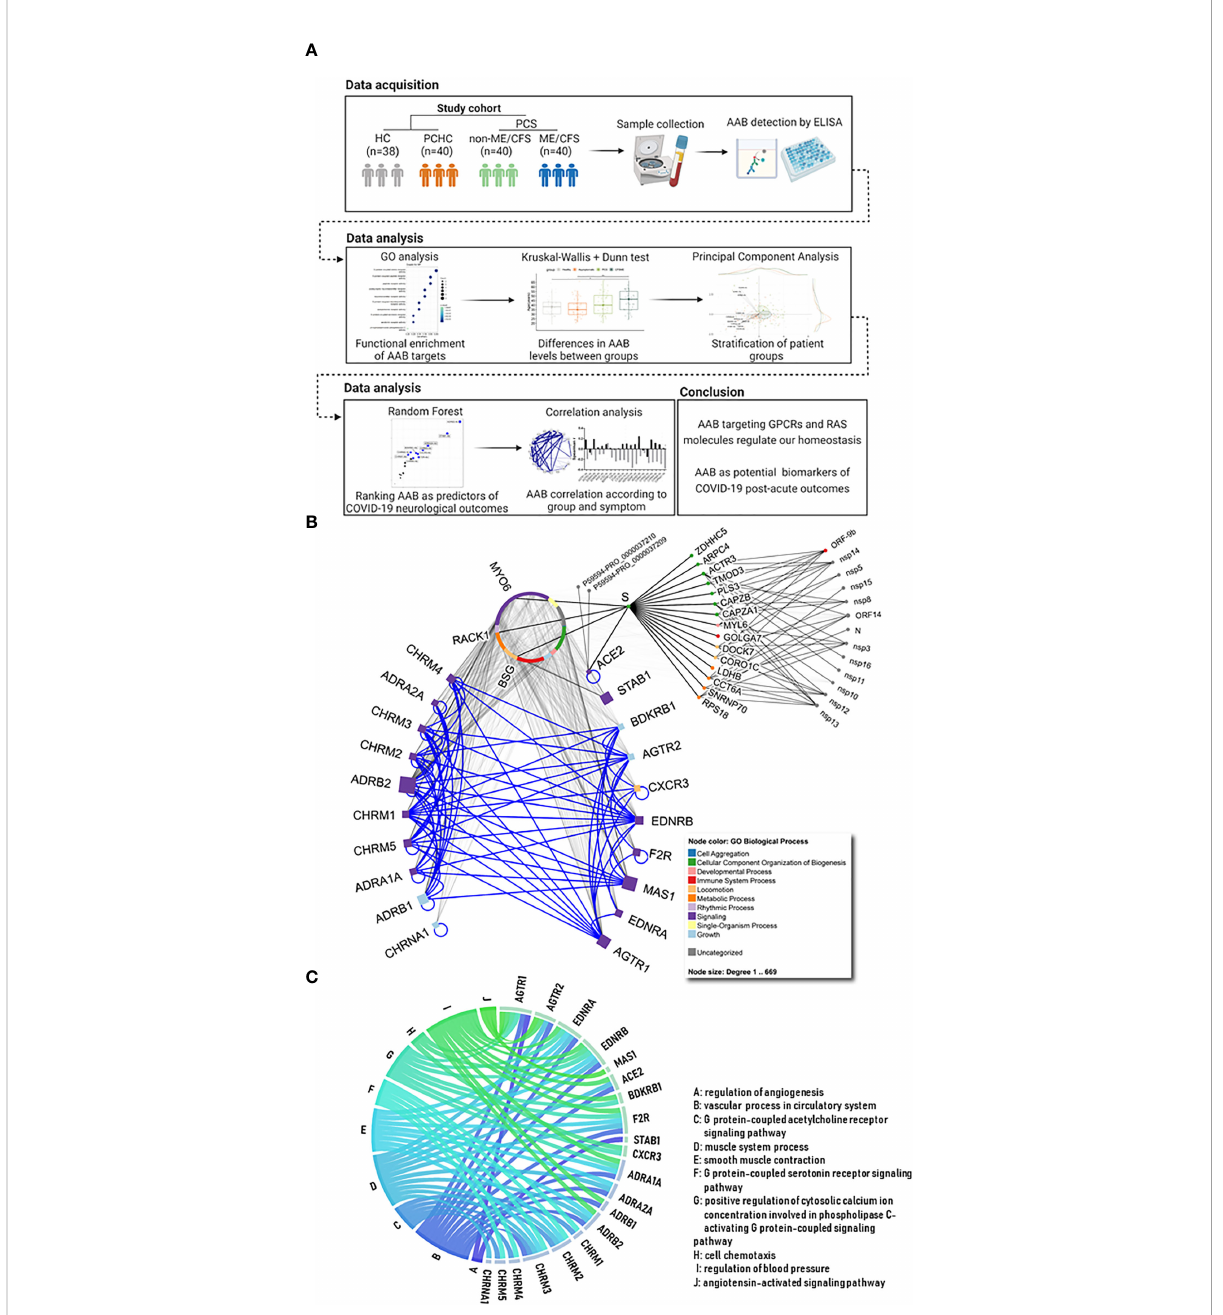
FIGURE 1 Study work fl ow and description of autoantibody targets. (A) After data acquisition, different statistical analyses (written on the top) were carried out in order to characterize the signature of autoantibodies (AAB) against G protein coupled receptors (GPCRs) and COVID-19-associated molecules (e.g. renin-angiotensin system (RAS)) in Post COVID Syndrome (PCS) when compared with healthy controls (HC) and post COVID-19 healthy controls (PCHC). Created with Biorender. (B) The 10 squares on the left represent autonomic nervous system (ANS) related receptors, while the 10 on the right show non-ANS molecules and receptors (e.g. RAS, immune and circulatory systems). Blue edges in the network highlight the interactions among the AAB targets, while gray edges represent other interactions. Node colors map to Gene Ontology (GO) biological processes (BPs) and node size corresponds to number of interacting partners for each target. Circular nodes represent human and SARS-CoV-2 molecules (as well as two Spike (S) proteins with unspeci fi ed roles) that are described in the IMEx coronavirus interactome. Circular organization of the proteins on the top middle of the image represent interacting partners of the AAB targets (names are omitted, except for 3 proteins that link ACE2 via S). (C) Circular plot with targets and relevant pathways they are associated to. Edge colors differ between each pathway. Edges representing AAB pathways are named from A to J, and the corresponding name is present in the